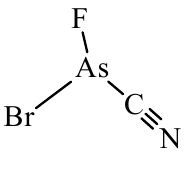
Figure 4. Computed electrostatic potential on the 0.001 au molecular surface of AsFBr(CN), 6 . In ( a ), the arsenic is in the foreground, the bromine is to the lower left and the CN is to the lower right. In ( b ), the fluorine is in the foreground to the left, the bromine is in the foreground to the right and the CN is at the top. Color ranges, in kcal/mol: red, greater than 30; yellow, between 30 and 15; green, between 15 and 0; blue, less than 0 (negative). The black hemispheres show the locations of the locally most positive potentials, the V S,max . In ( a ) can be seen the three V S,max on the arsenic, and in ( b ) the one on the bromine.